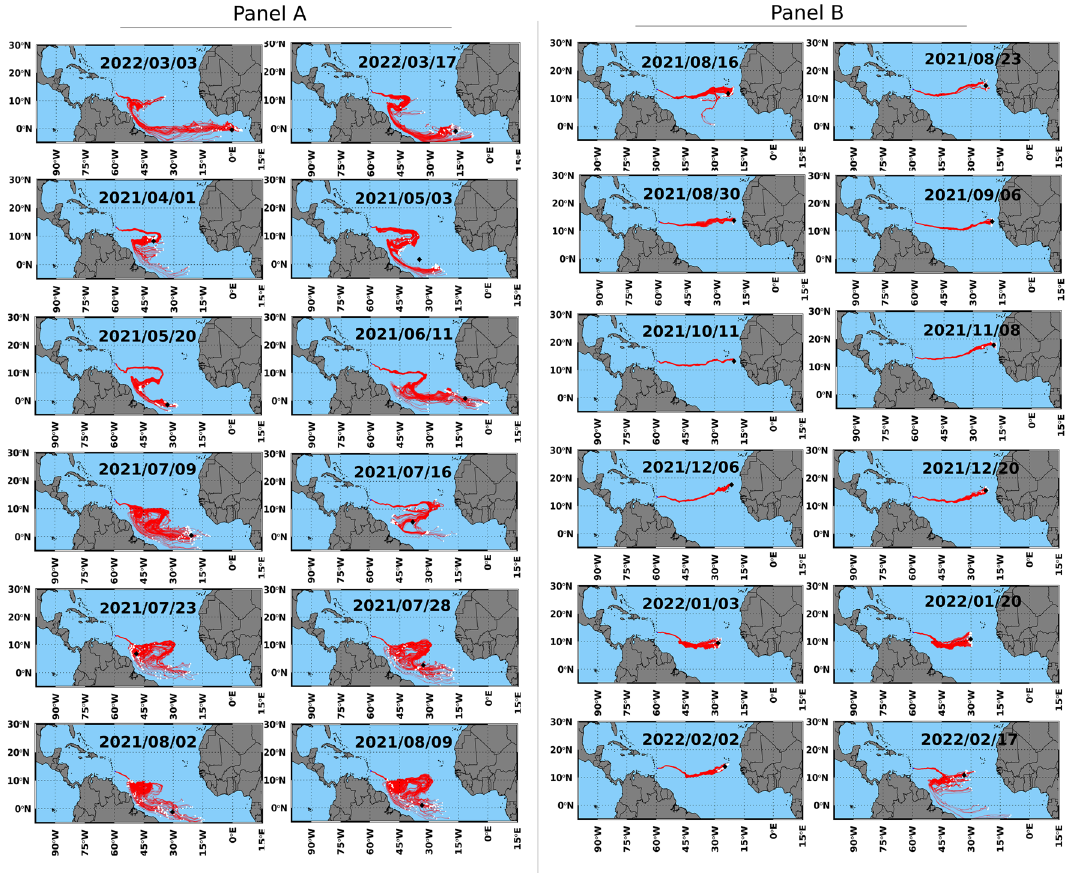
Figure 3. Backtracks of Sargassum (mixed-morphotype samples) collected from Morgan Lewis beach in Barbados over the period of 1 year (2021–2022). Panel ( a ) shows sample backtracks from early March to early August and panel ( b ) shows backtracks from late August through February. All backtracks were run over a 365-day period using 100 particles. White dots indicate the origin of each backtrack particle (i.e., the backtrack location 365 days before arriving to Barbados) and the black square represents the origin of highest probability (mean of all backtrack particles). Dates are presented in year/month/day format. Maps were generated using